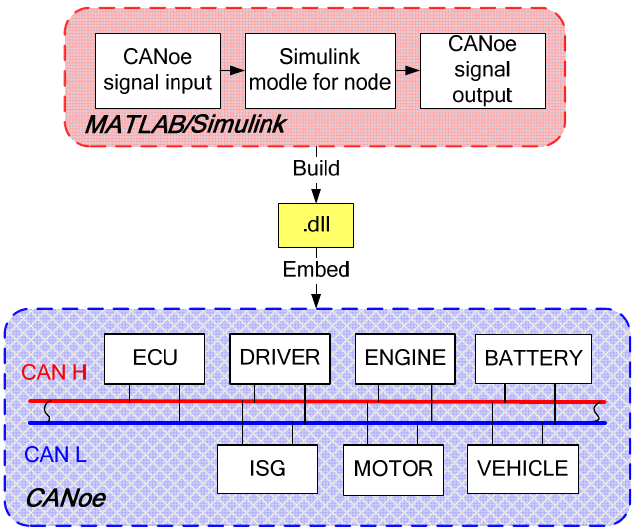
Figure 11. The co-simulation schematic of plug-in school